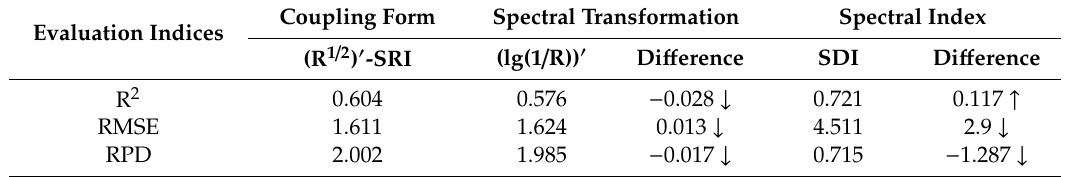
Table 8. Reliability comparison of optimal evaluation indexes in single and coupling